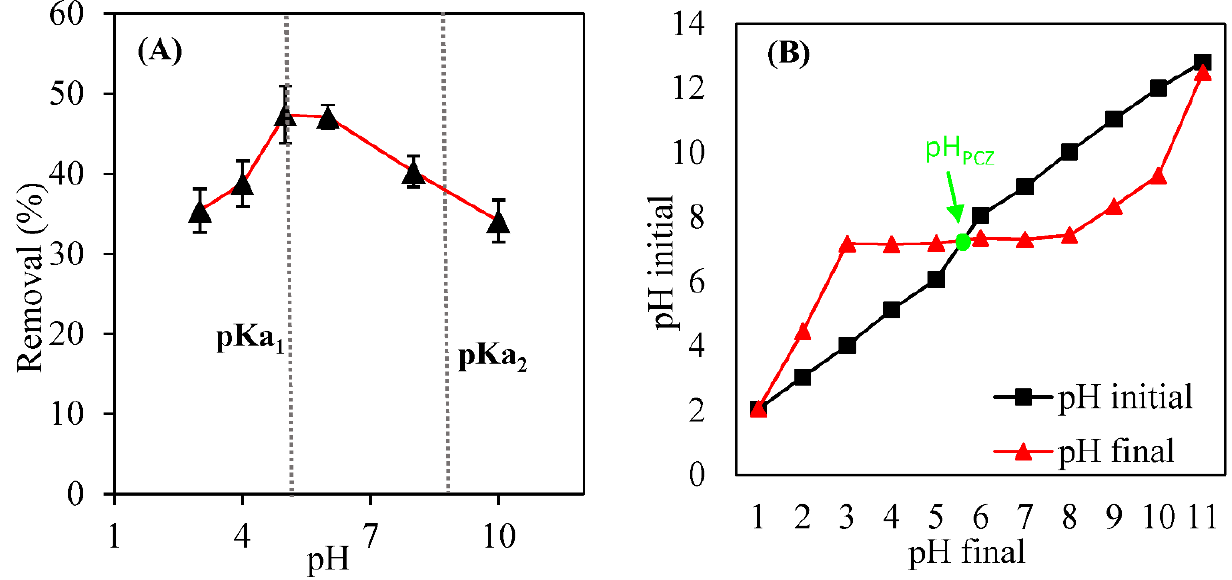
Figure 5. ( A ) Effect of pH on the removal capacity of the CPX and ( B ) the zero charge point pH.